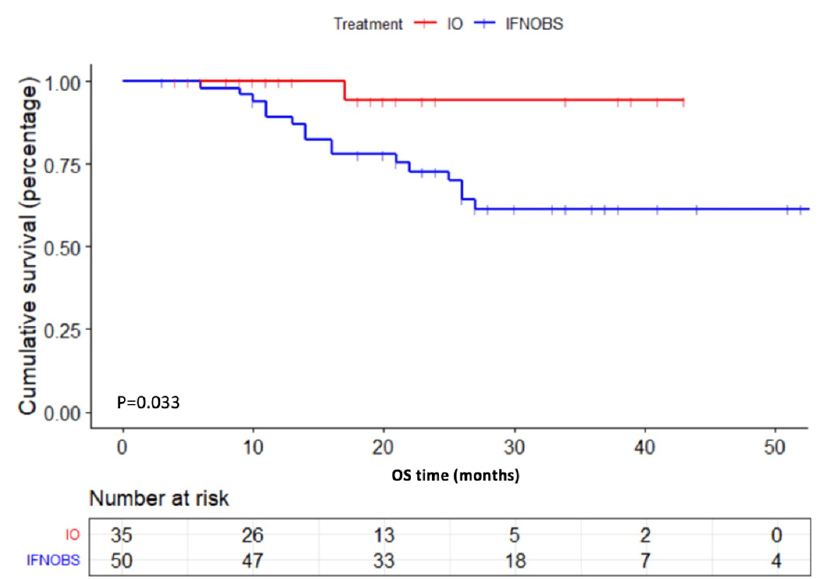
Figure 4. OS for all enrolled acral and cutaneous melanoma patients stratified by adjuvant PD-1 inhibitor treatment versus conventional treatment (IFN+OBS) ( p = 0.033).